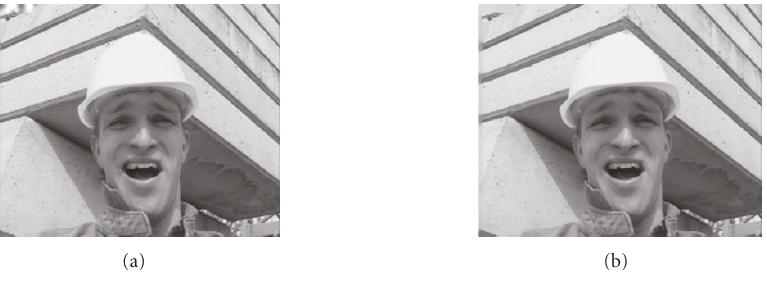
Figure 14: Reconstruction results of the “Foreman” with the original size. (a) Laplacian regularization and (b) TV regularization.